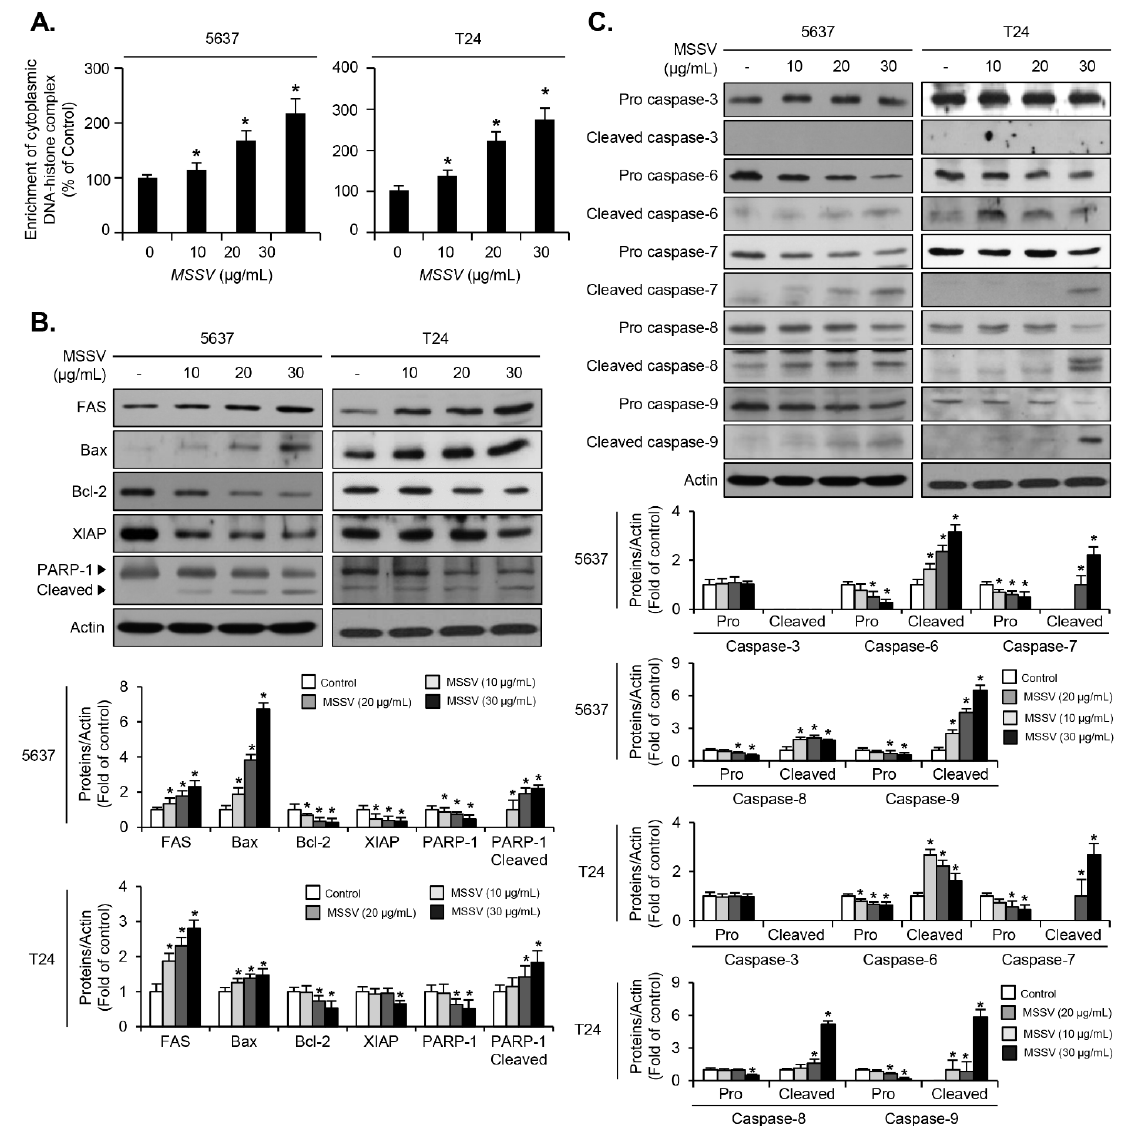
Figure 5. Effect of MSSV on apoptosis signaling in both bladder cancer cells. Both cells were exposed to MSSV at the indicated concentrations for 24 h. ( A ) Detection of apoptosis via measurement of cytoplasmic DNA-histone complex. After the treatment of cells with MSSV, supernatants containing cytoplasmic histone-associated DNA fragments were determined using ELISA assay. ( B ) Whole-cell lysates were subjected to immunoblot analysis with anti-FAS, anti-Bcl-2, anti-Bax, anti-XIAP, anti-PARP-1, and anti-Actin. ( C ) Expression levels of pro and cleaved forms of cascase-3, cascase-6, cascase-7, cascase-8, and cascase-9 were analyzed via immunoblotting. Actin was used as the internal control. Bar graphs show relative fold changes in the protein levels at different concentrations of MSSV compared with the control. For the bar graphs, values are presented as the mean ± SD of three independent experiments; * p < 0.05, compared with the control group. Uncropped Western Blot Images in Figure S7 and Figure S8.